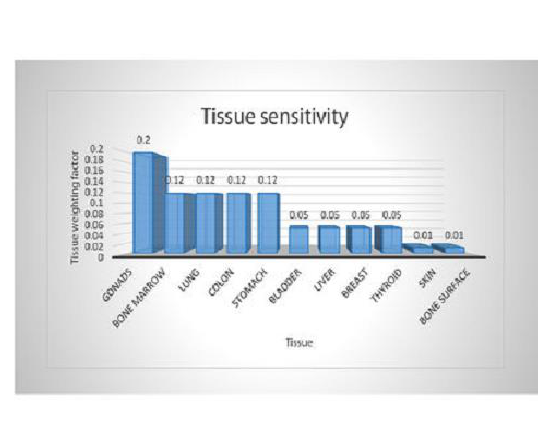
Figure-1 Tissues sensitivity to radiation (mSv )